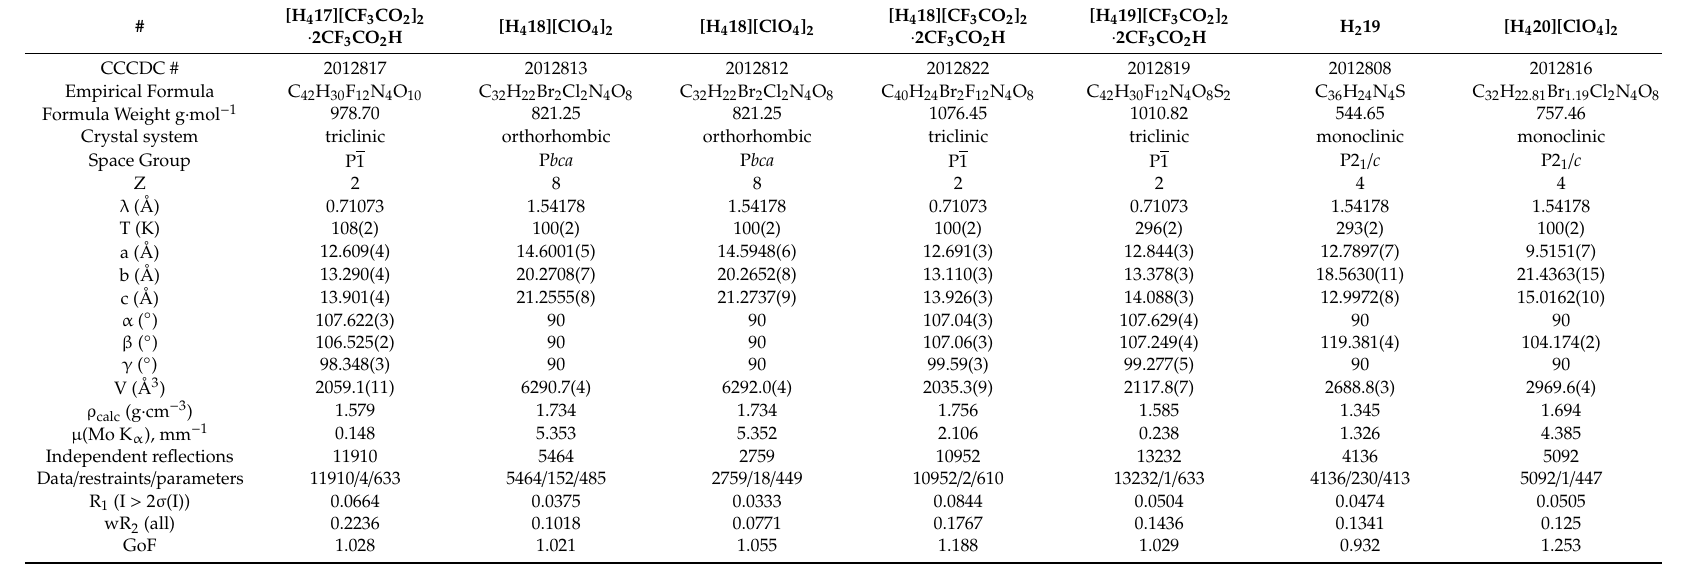
Table 2. Crystallographic tables for compounds